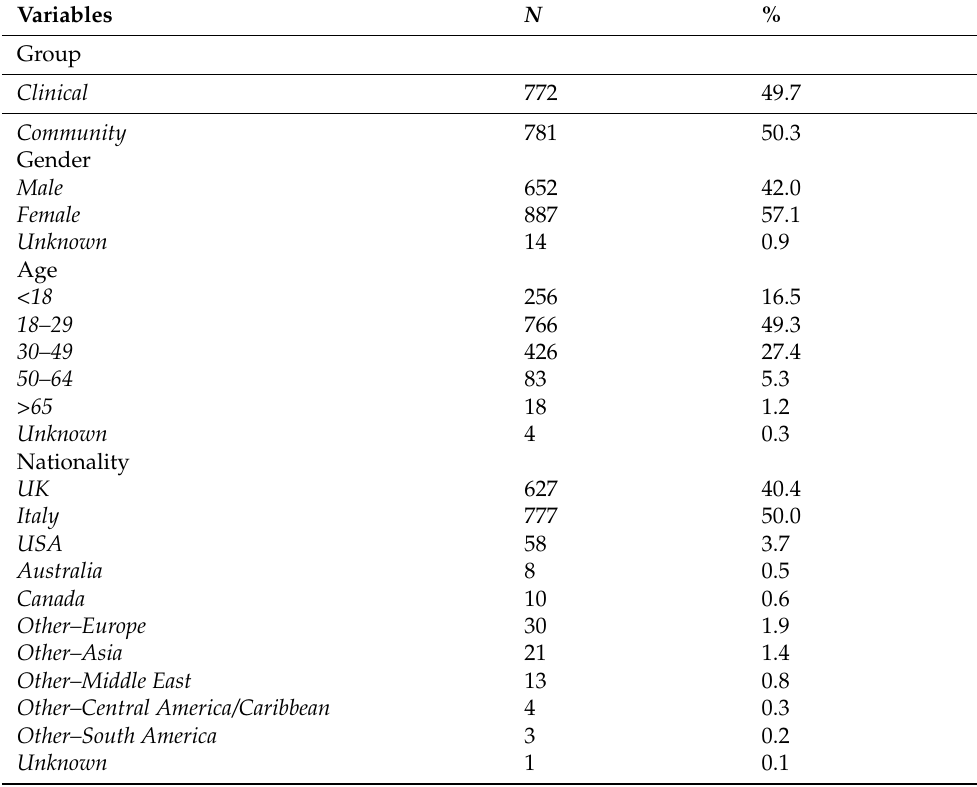
Table 2. Demographic characteristics of the full